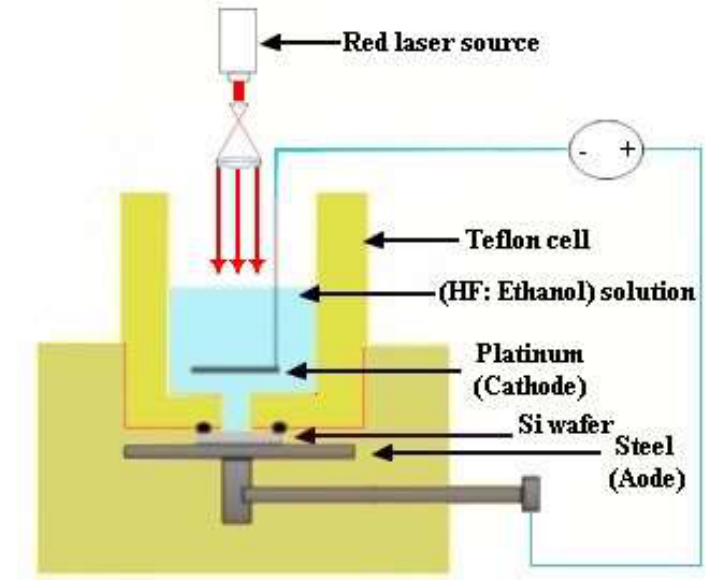
Figure 1: The Schematic drawing of the PECE